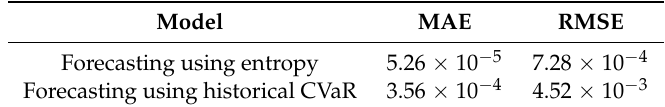
Table 4. Backtest results of daily CVaR at the significance level α =